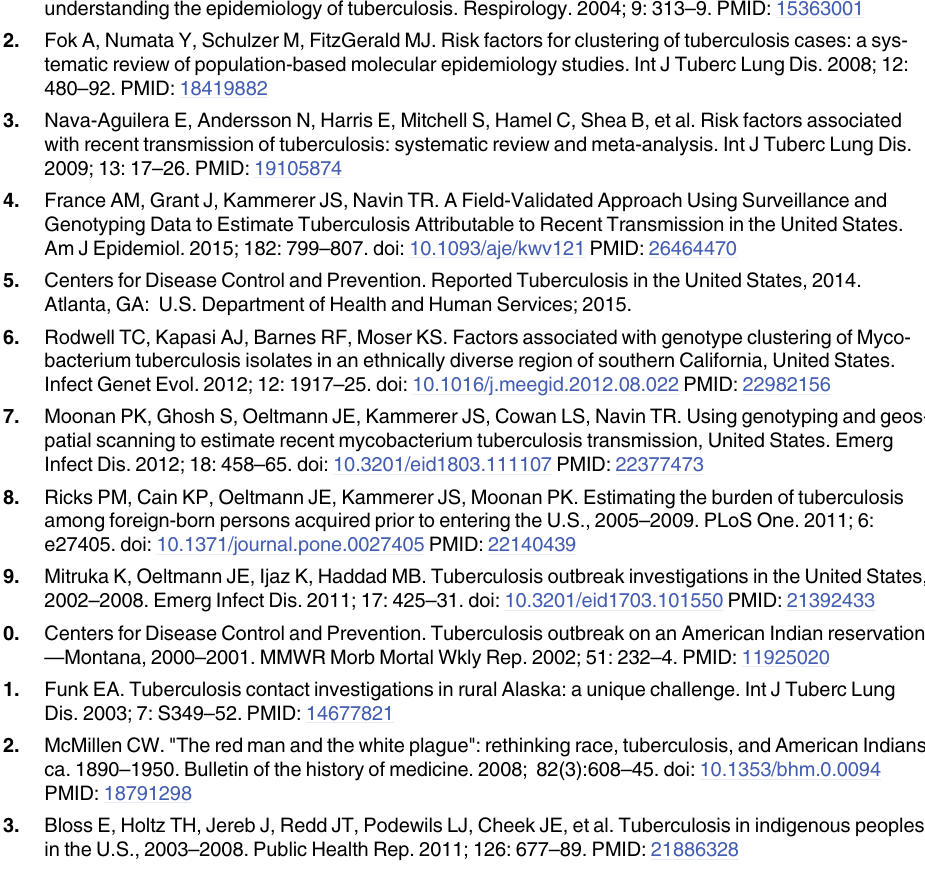
S1 Table. Results of sensitivity analysis showing impact of changing cluster size threshold. Adjusted prevalence ratios (aPR) and 95% confidence intervals (CI) are shown for cases attrib- uted to limited or extensive recent transmission compared to cases not attributed to recent